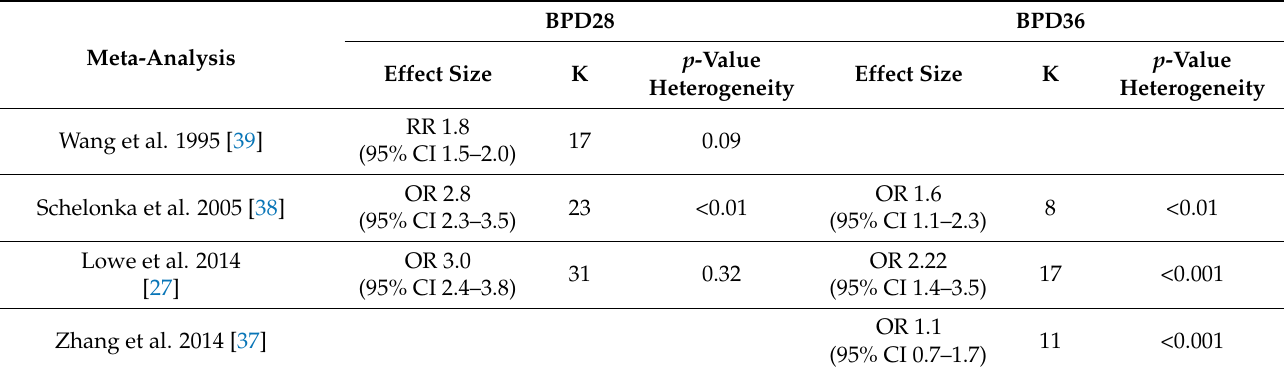
Table 1. Summary of meta-analyses on the association between neonatal pulmonary colonization with Ureaplasma and bronchopulmonary